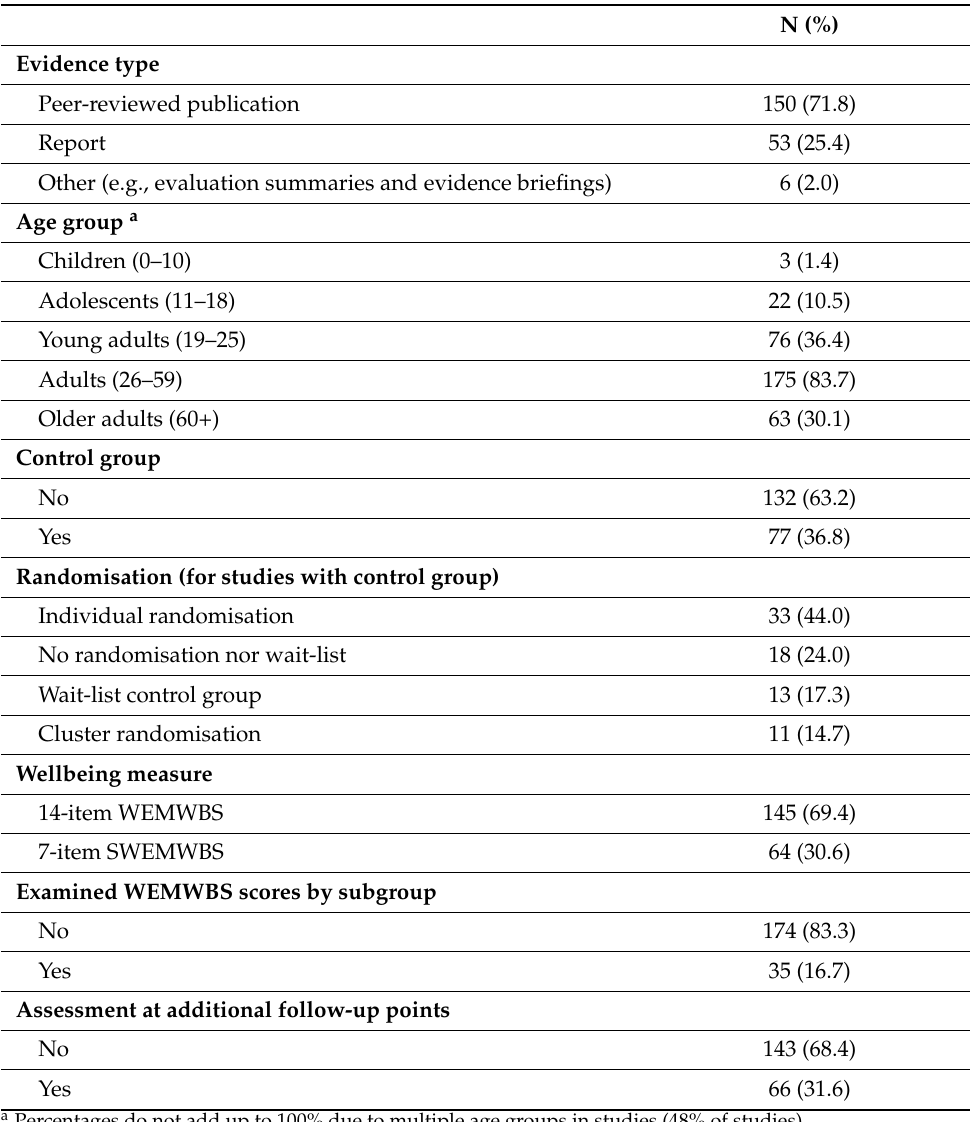
Table 1. Characteristics of all included studies (n = 209).